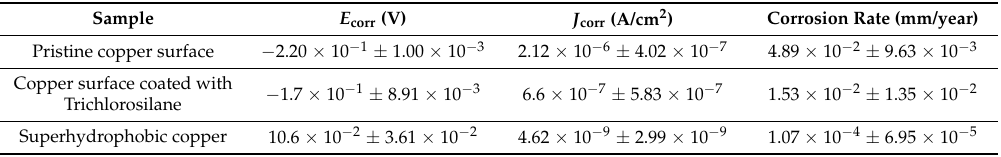
Figure 6. Potentiodynamic polarization curve obtained by using Ag/AgCl electrode as the reference electrode and 3.5 wt % NaCl solution as the electrolyte for pristine copper surface, copper surface coated with Trichlorosilane (reference surface), and superhydrophobic copper surface. Table 1. Corrosion Potential ( E corr ), Corrosion Current Density ( J corr ), and Corrosion Rate of the pristine copper surface, copper surface coated with Trichlorosilane (reference surface), and superhydrophobic copper surface.